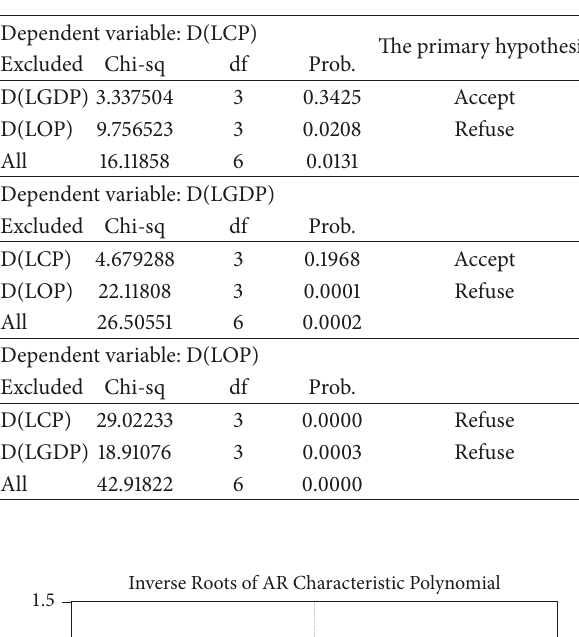
Table 8: Granger causality test.